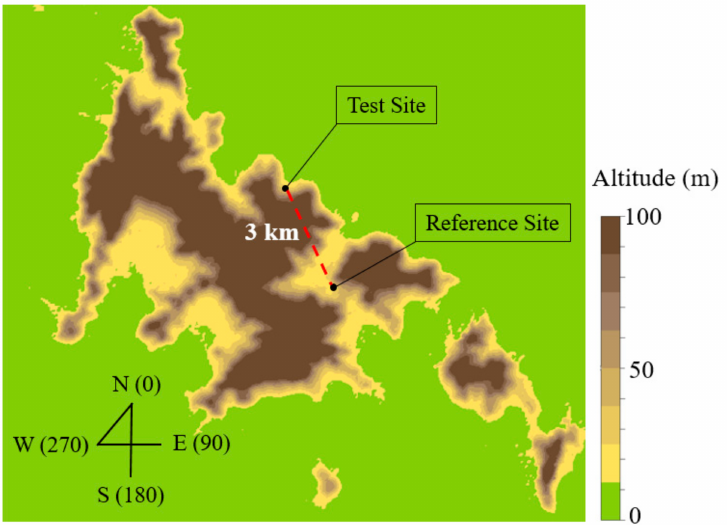
Figure 1. Geographical locations of the two